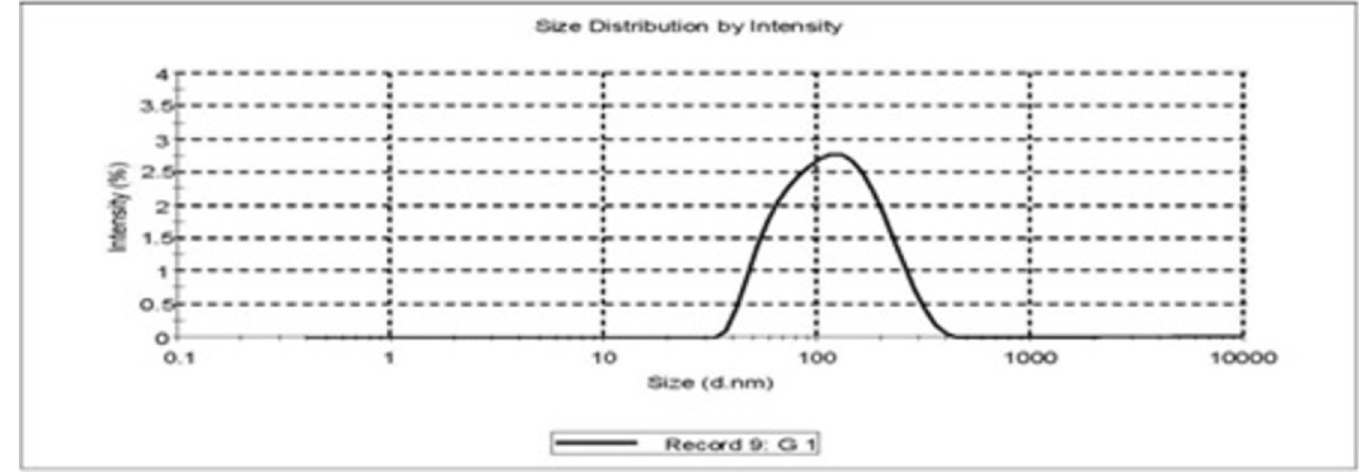
Fig 2. Vesicle size distribution of stealth liposomes (CL13). https://doi.org/10.1371/journal.pone.0264518.g002 Stability study was conducted for 6 months at accelerated temperature (25 ± 2˚C/60 ± 5% RH) and ambient temperature (5 ± 3˚C) for the freeze-dried product of CL13 (Stealth liposomes) and the data was compared with stability data of CL13 liposomal suspension. Comparative stability